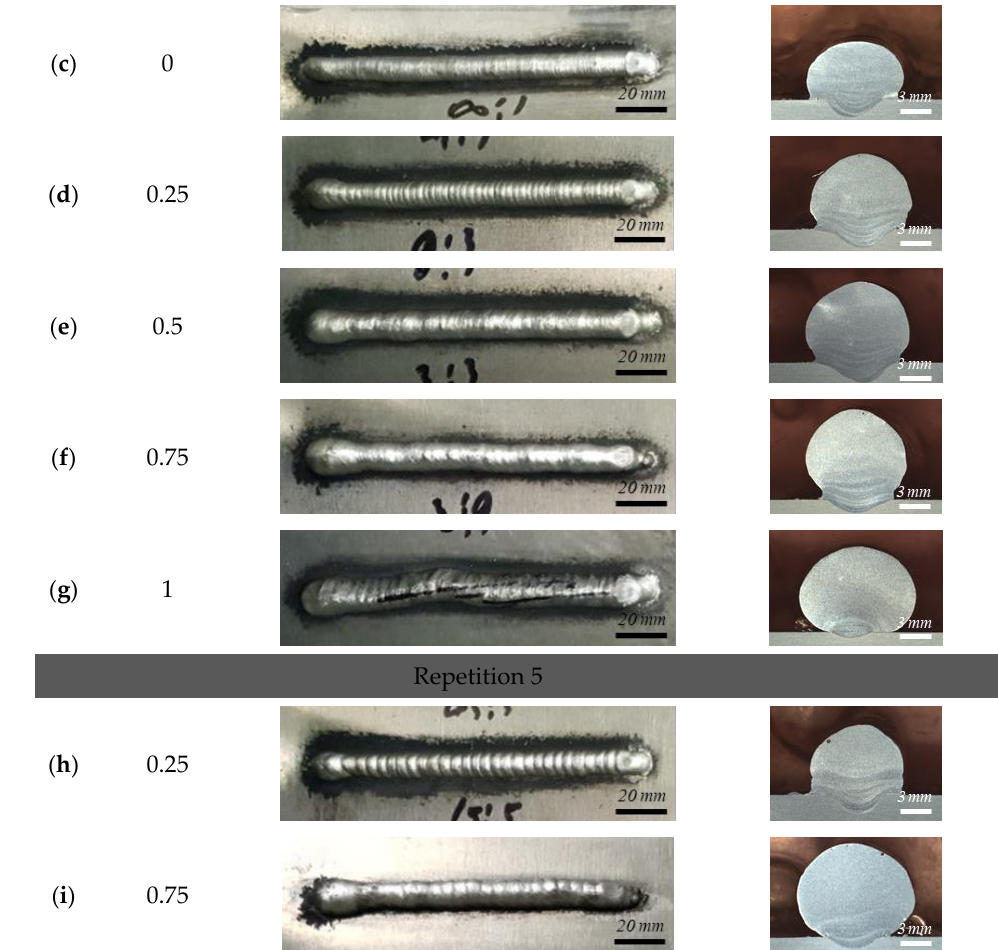
Figure 10. Bead appearance and cross-sectional images depending on R EN and repetition conditions. Specimens were fabricated at a welding speed of 0.5 m/min.